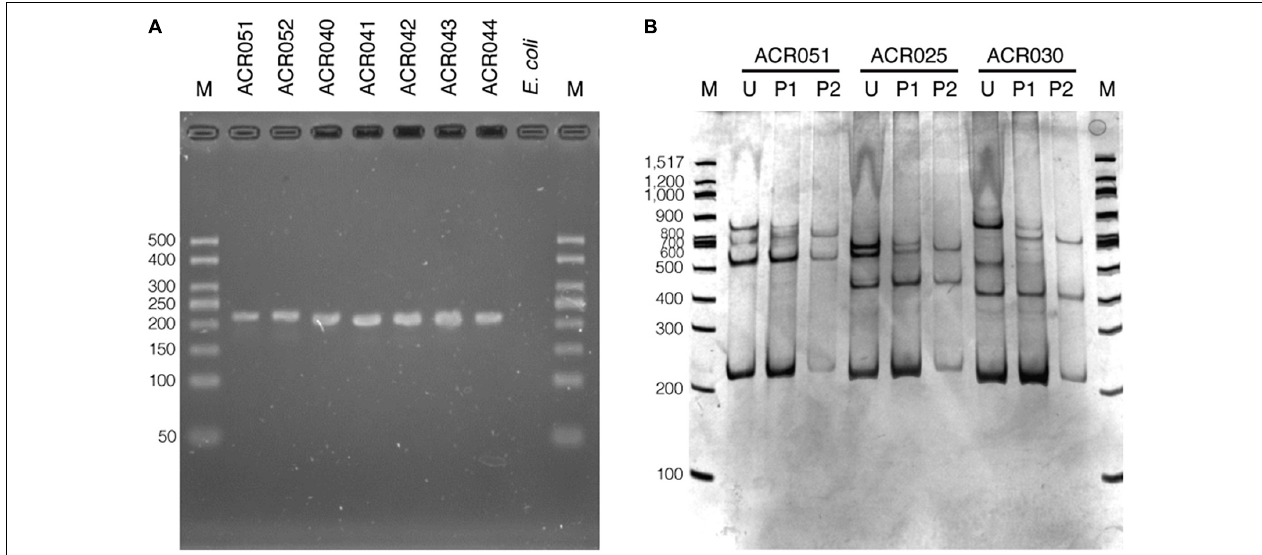
FIGURE 2 | The PCR amplification results using single-strand conformation polymorphism (SSCP) primers and the effects of the amplicon purification methods on the SSCP fingerprint method. The PCR amplicons were amplified using the SSCP primers (SSCP6_F and SSCP6_R) and the genomic DNA templates extracted from each isolate of dictyostelids (A) . Lane M represents the 50-bp DNA ladder (Vivantis, Malaysia) followed by seven lanes of PCR amplicons including Cavenderia sp. ACR051, Cavenderia sp. ACR052, Dictyostelium sp. ACR040, Dictyostelium sp. ACR041, Dictyostelium sp. ACR042, Dictyostelium sp. ACR043, and Dictyostelium sp. ACR044. The genomic DNA of Escherichia coli was used as a negative control. The polyacrylamide gel electrophoresis (PAGE) of SSCP fingerprint of three isolates of dictyostelids was performed, including Cavenderia sp. ACR051, Polysphondylium sp. ACR025, and Dictyostelium sp. ACR030 (B) . The SSCP fingerprint from each isolate was generated from the unpurified amplicons (U), directly purified amplicons (P1), and gel purified amplicons (P2). The 9% PAGE was run at 130 V, 4 ◦ C for 3 h followed by silver staining. DNA marker (M) in the PAGE was 100-bp DNA ladder (New England Biolabs, United